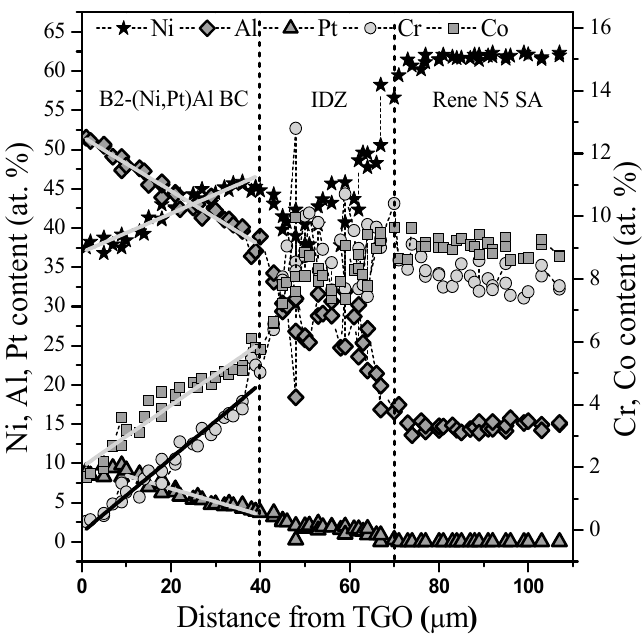
Figure 1. Concentration profiles of a cross section reference sample obtained from EPMA, starting from the BC surface, through the IDZ zone up to the SA.